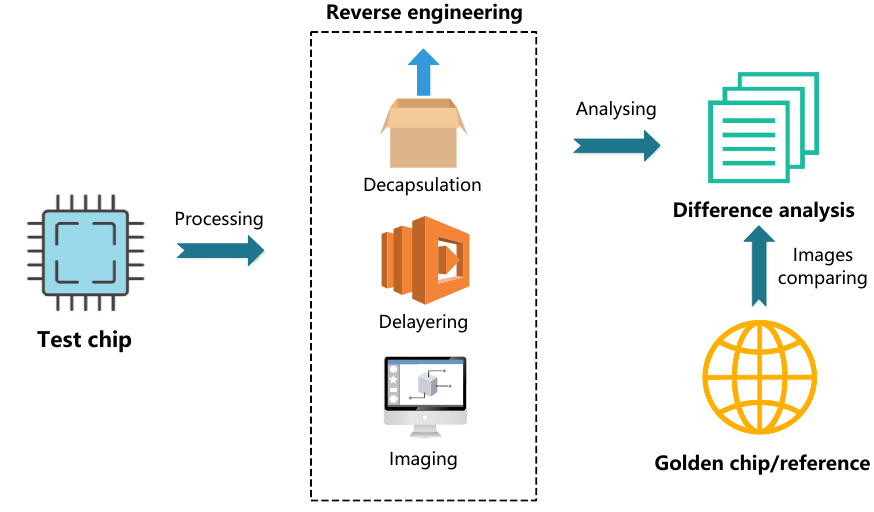
Figure 12. Reverse engineering extracts the chip structure images to detect